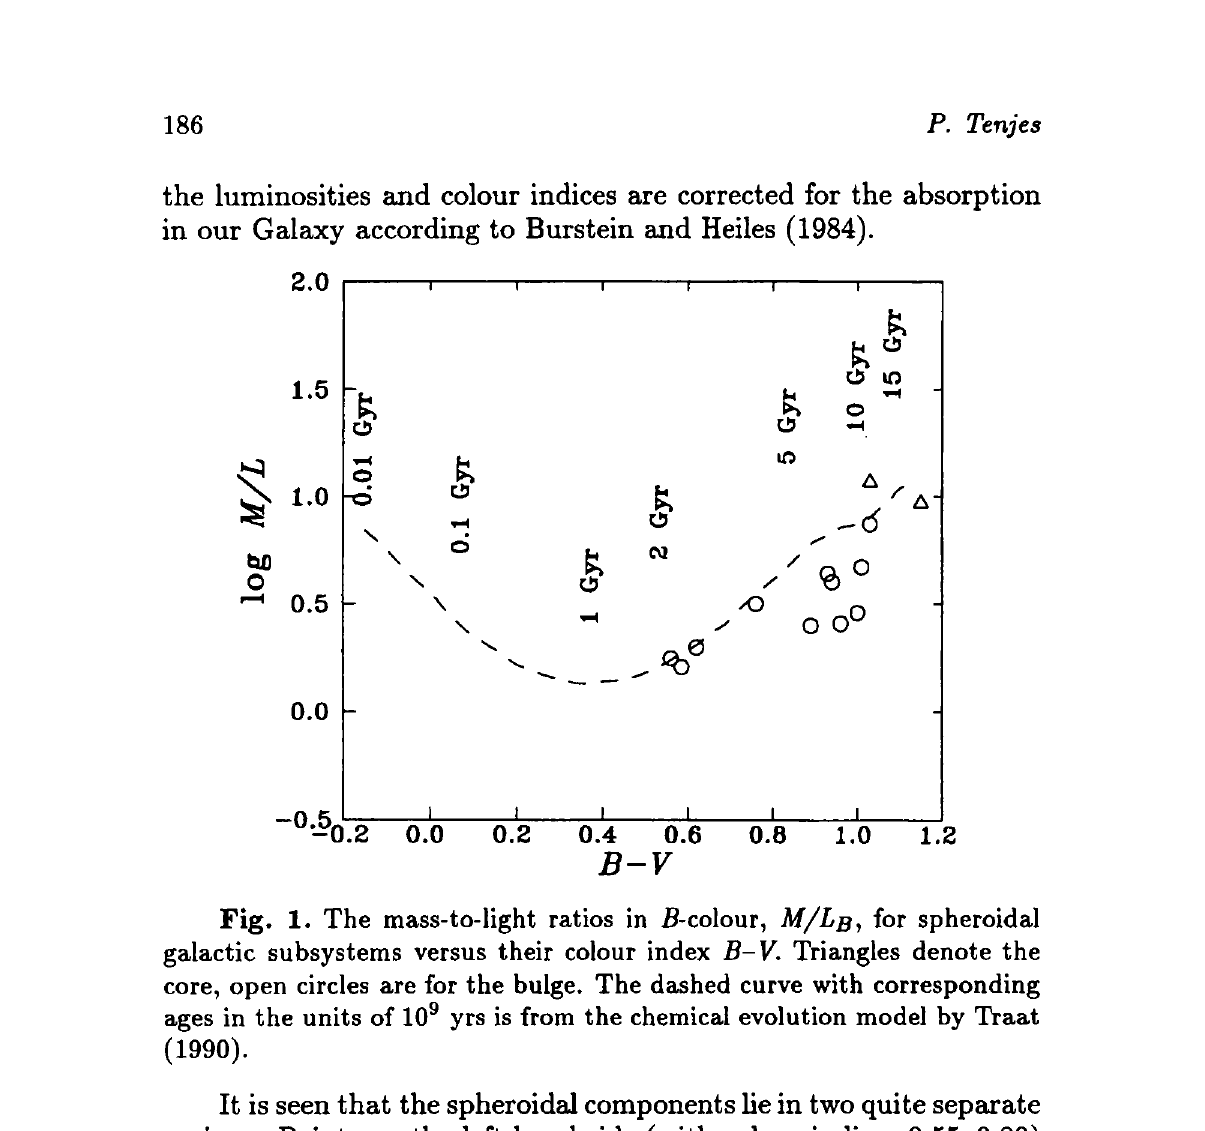
Fig. 1. The mass-to-light ratios in ß-colour, M/Lg, for spheroidal galactic subsystems versus their colour index B-V. Triangles denote the core, open circles are for the bulge. The dashed curve with corresponding ages in the units of 10 9 yrs is from the chemical evolution model by Traat